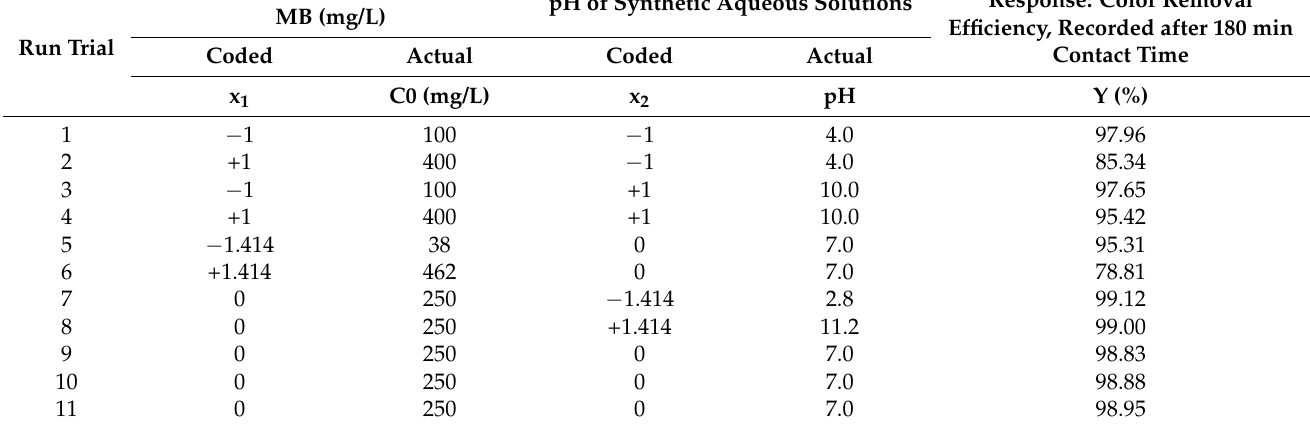
Table 3. Central composite experimental design of rotatable type used for studying and enhancement of the adsorption system (SPEEK/MB dye); fixed conditions for experimentations: sorbent dose SD = 2 g/L; contact time t = 180 min; and temperature T = 323 K (50 ◦